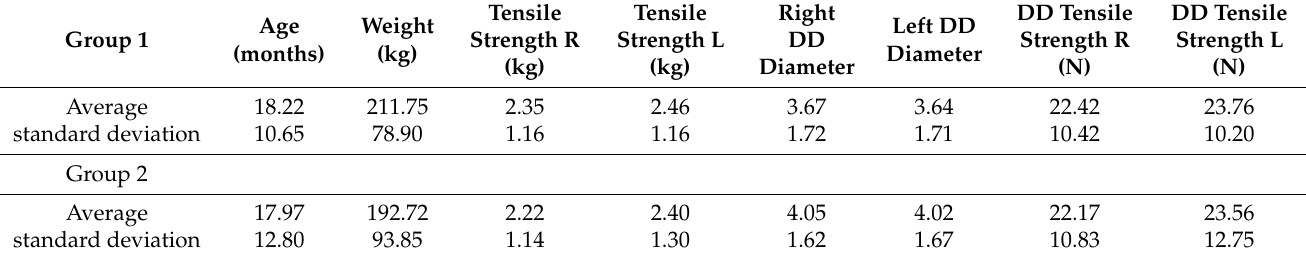
Table 1. Average and standard deviation of variables recorded for groups 1 and 2; R: right; L: left; DD: deferens